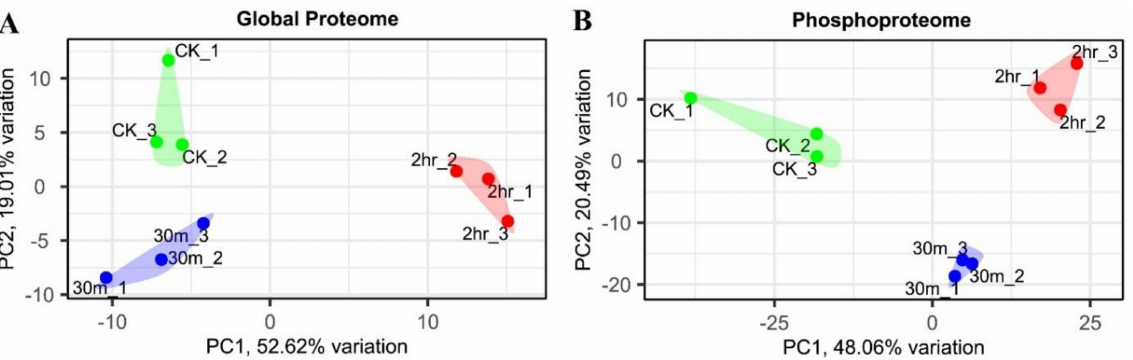
Figure 2. PCA analysis of the global proteome ( A ) and phosphoproteome ( B ) samples. The control samples (CK), the 30 min, and the 2 h samples are well separated on the PCA plots in both the global proteome and the phosphoproteome